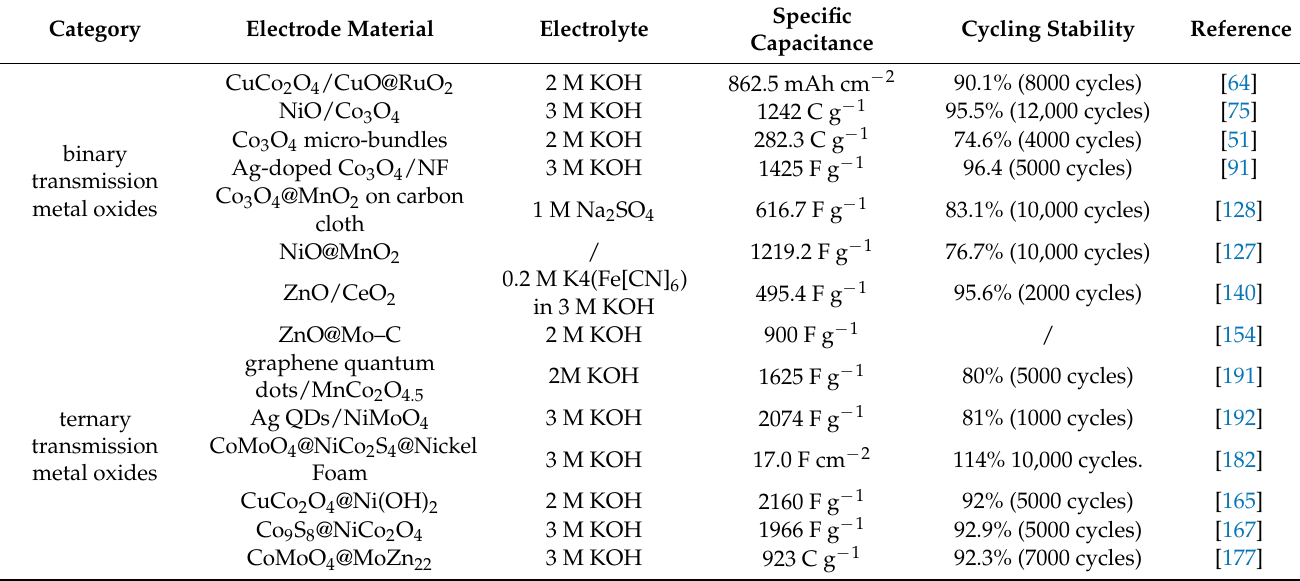
Table 2. The performance of electrodes based on binary and ternary TMOs.